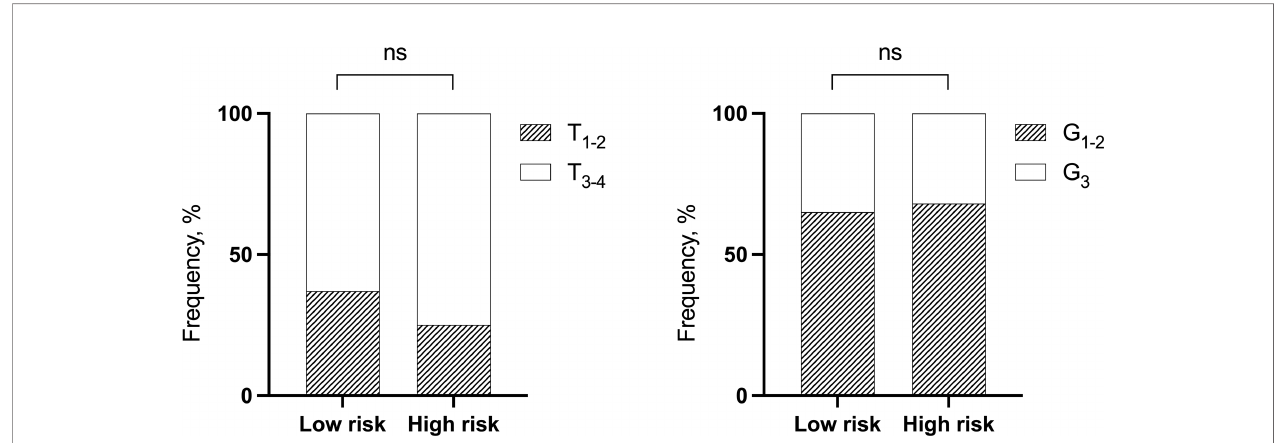
FIGURE 2 | The distribution of NSCLC patients by T and grade depending on low- and high-risk groups of distant metastases. Fisher ’ s exact test. NSCLC, non- small cell lung cancer; ns, not signi fi